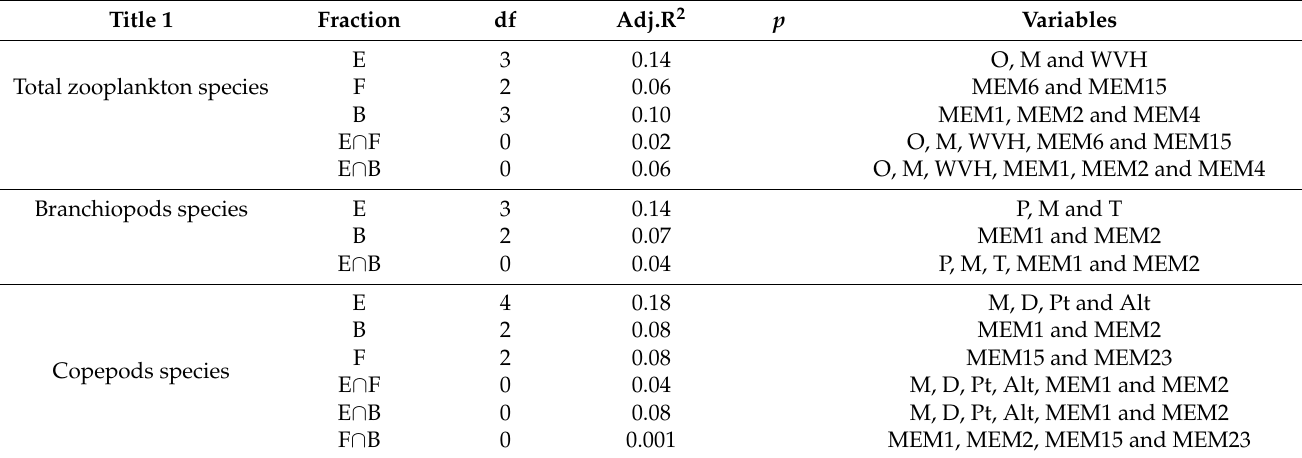
Table 3. Results of RDA and variation partitioning showing the contributions of environmental and